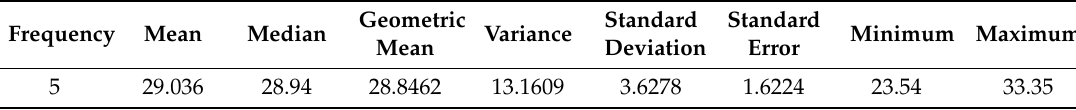
Table 3. Values of shear strength in MPa of five samples tested.